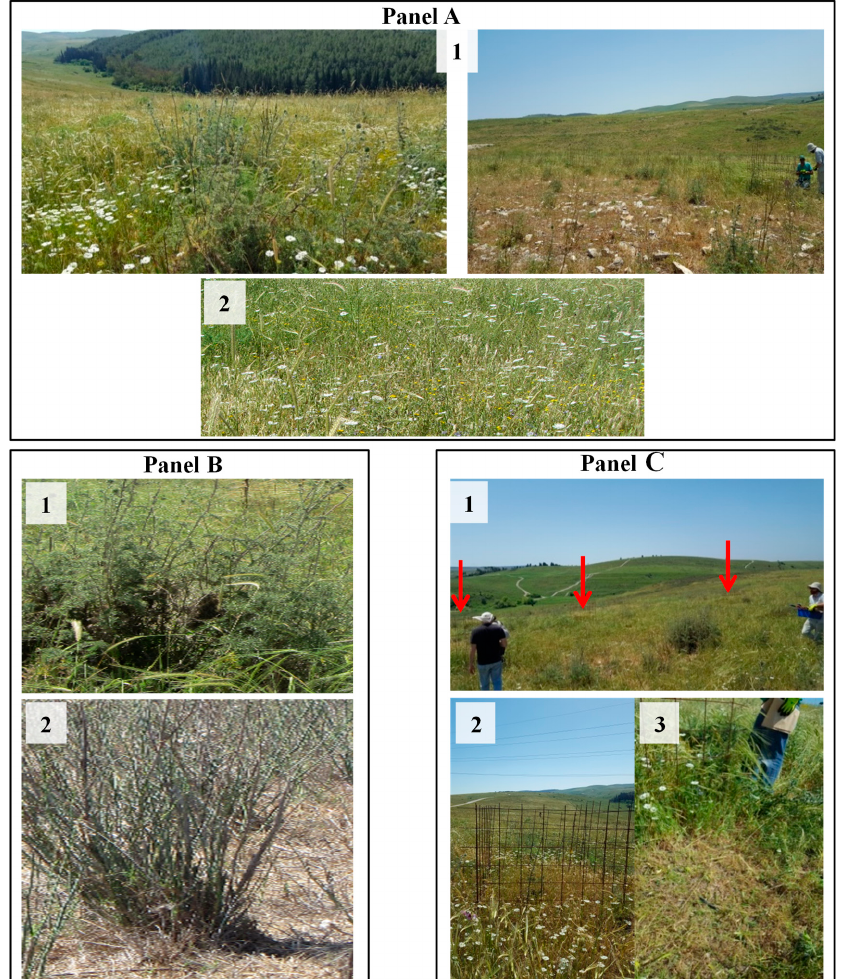
Figure 3. Views of the study area, representative vegetation samples, and sampling approach. Panel A. 1. Views of the study area; 2. Diversity of annual cereals . P anel B. The dominant perennials: 1. 1. Views of the study area; 2. Diversity of annual cereals. Panel B . The dominant perennials: 1. Echinops Echinops polyceras ; 2. Foeniculum vulgare mill. Panel C. 1. Ecological approach: cross-section sampling; polyceras ; 2. Foeniculum vulgare mill. Panel C . 1. Ecological approach: cross-section sampling; 2. Fenced 2. Fenced plot as control with no grazing; 3. Plot after biomass harvesting. plot as control with no grazing; 3. Plot after biomass